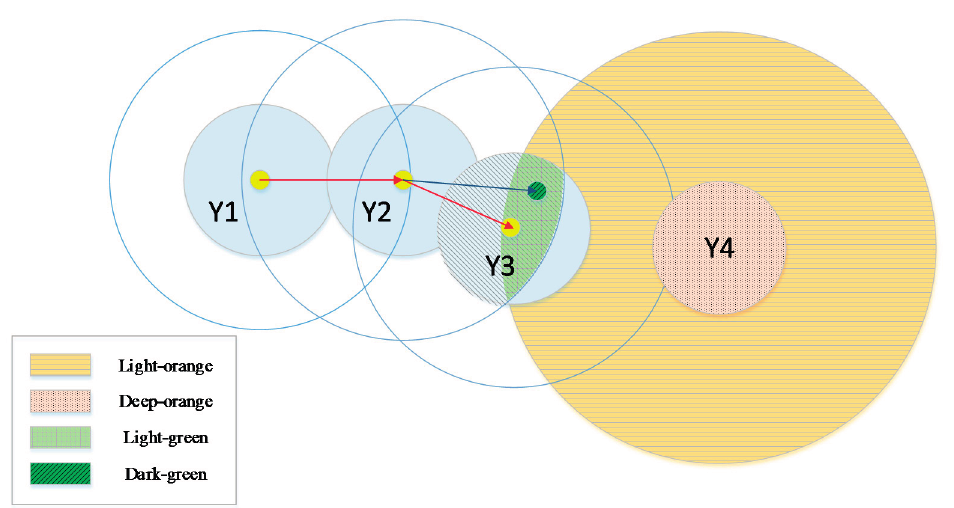
Figure 7. Flow diagram of HMM location